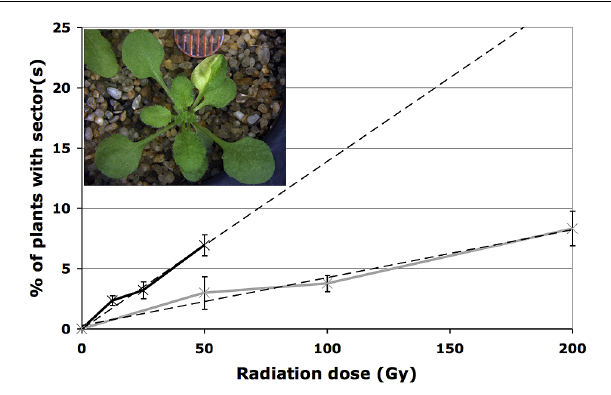
FIGURE 2 | Loss of heterozygosity following exposure to radiation. Loss of heterozygosity in wild-type plants treated with HZE (black line) and gamma (gray line) radiation. Data points represent the mean of three biological replicates; dashed lines depict linear regressions of datasets. Error bars depict standard deviation, as calculated by standard statistical methods in Mircosoft Excel. Inset: example of an IR-induced albino sector.